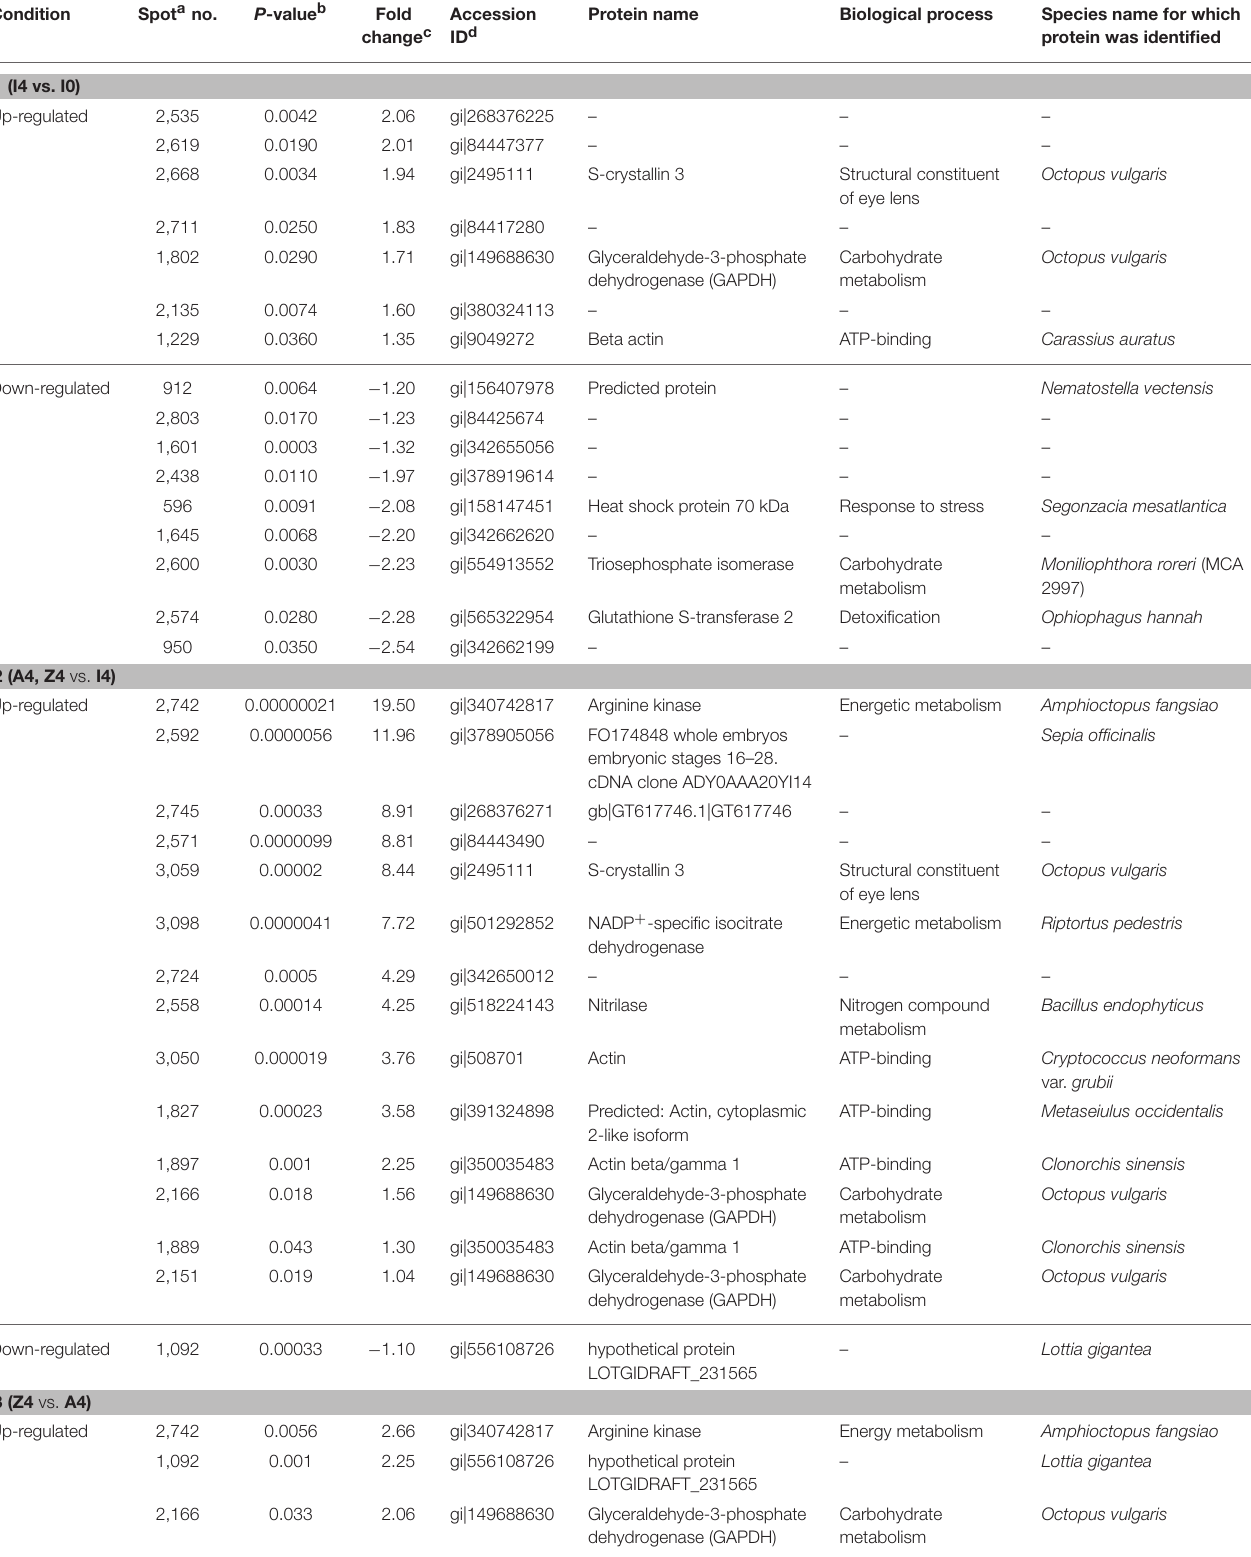
TABLE 1 | Protein identities differentially expressed in Octopus vulgaris paralarvae in the different conditions studied as function of dietary group and age. Condition Spot a